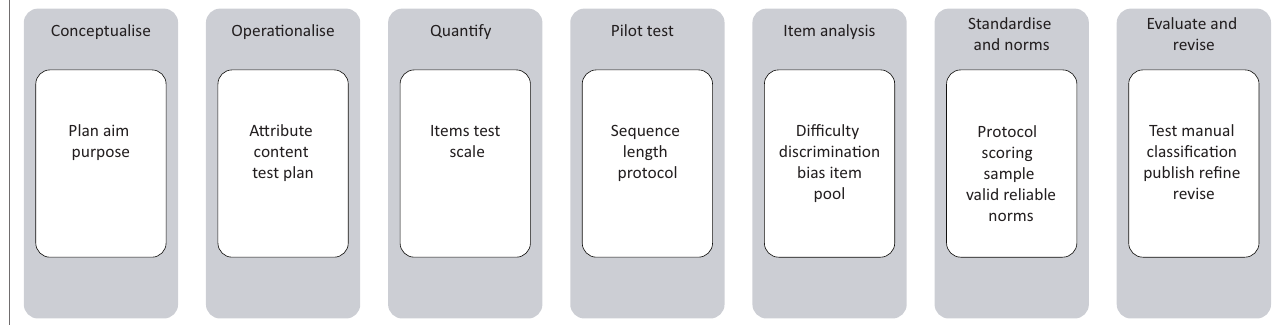
FIGURE 1: Outline of phases involved in psychological measure development.